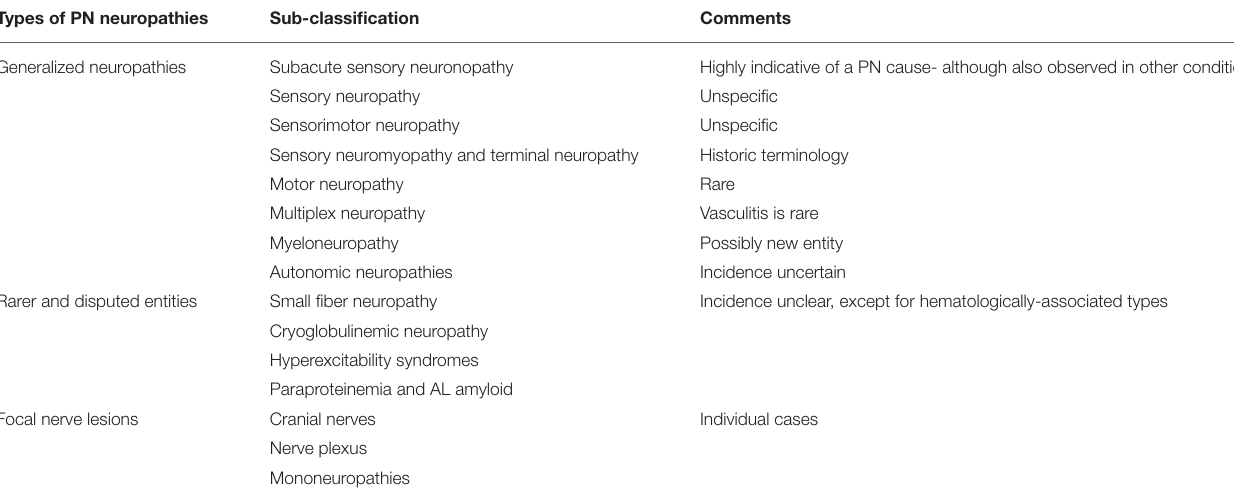
TABLE 4 | Classification of paraneoplastic